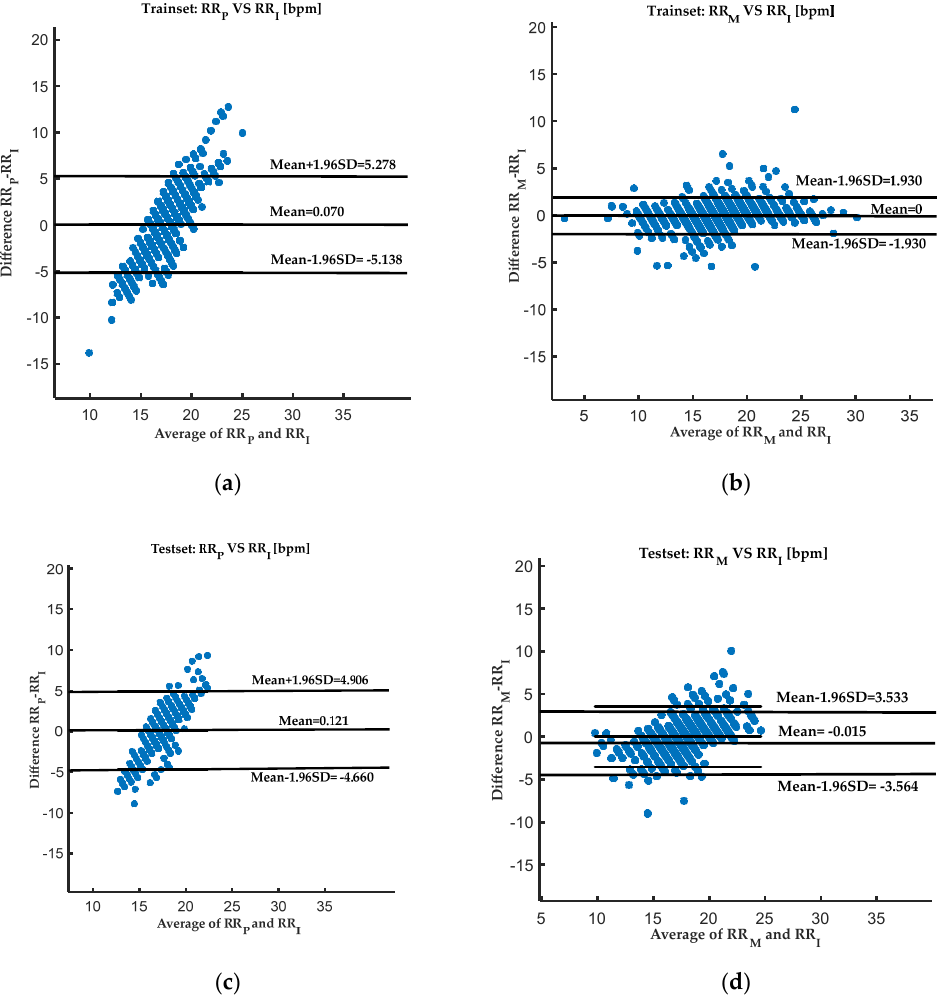
Figure 4. Bland–Altman plot of the RR M (RR estimated by the prediction model proposed in this study), RR P (RR estimated by the EEMD-PCA method), and RR I for the training set and test set. The figure includes a total of 3 lines for each method, with the middle line indicating the mean of the differences, and the upper and lower lines showing the upper and lower limits, respectively, of the 95% consistency limits. The horizontal axis represents the average of RR P and RR I or the average of RR M and RR I , and the vertical axis represents the difference, RR P -RR I or RR M -RR I : ( a ) Bland–Altman plot of the RR M and RR I in the training set, ( b ) Bland–Altman plot of the RR p and RR I in the training set, ( c ) Bland–Altman plot of the RR M and RR I in the test set, and ( d ) Bland–Altman plot of the RR p and RR I in the test